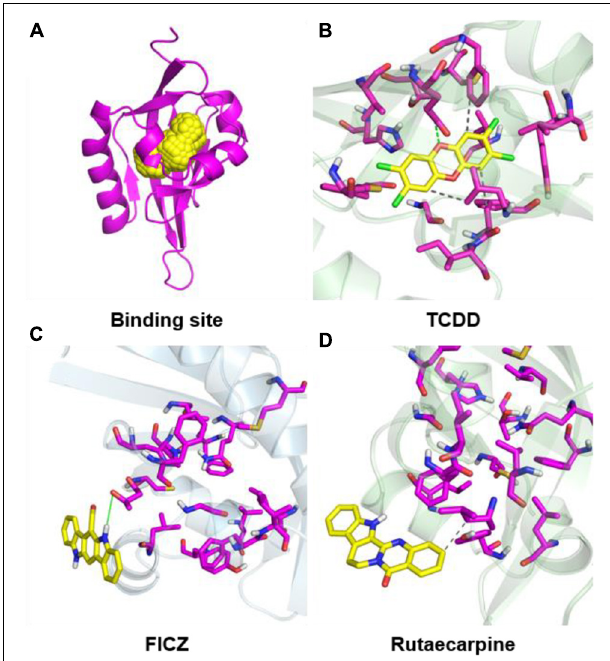
FIGURE 6 | Molecular docking configurations of TCDD, FICZ, and rutaecarpine with AhR. (A) AhR_HUMAN binding site map. The secondary structure of the protein was shown by magenta bands and the binding sites were shown by yellow spheres. (B) Docking of TCDD into the AhR binding pocket. (C) Docking of FICZ with the AhR protein model. (D) Docking of rutaecarpine with the AhR protein model.